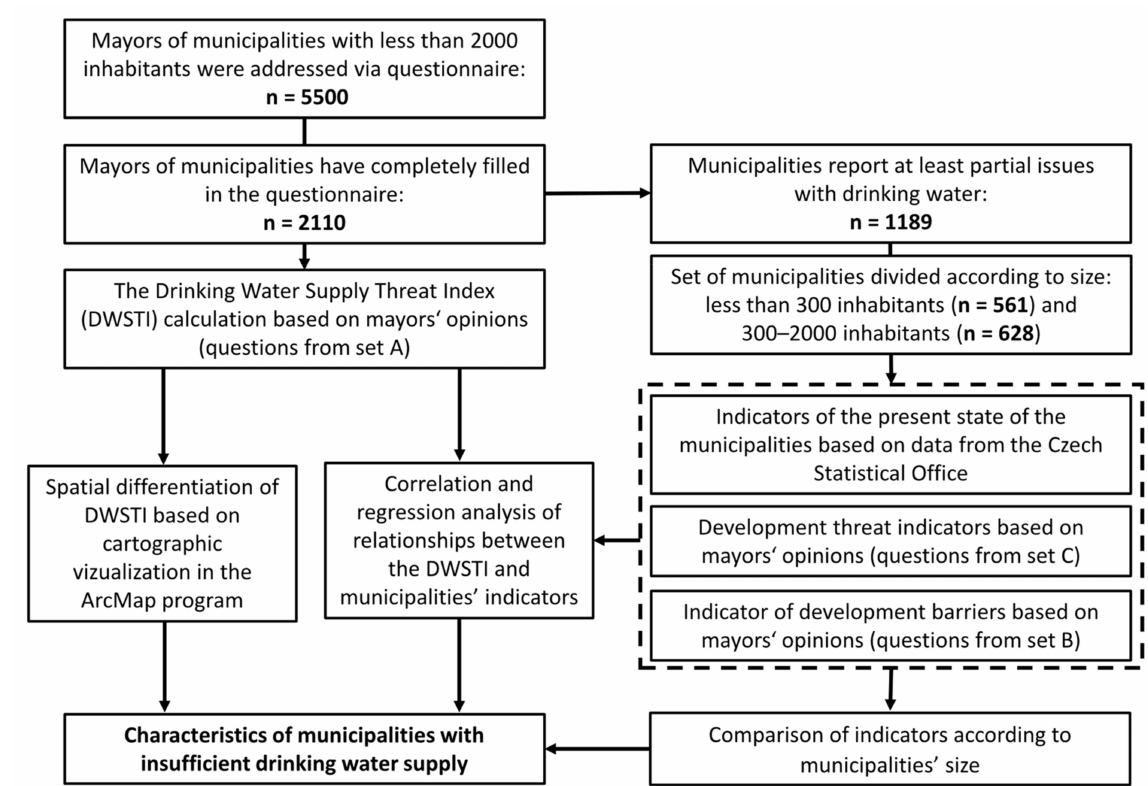
Figure 4. Flow chart of the